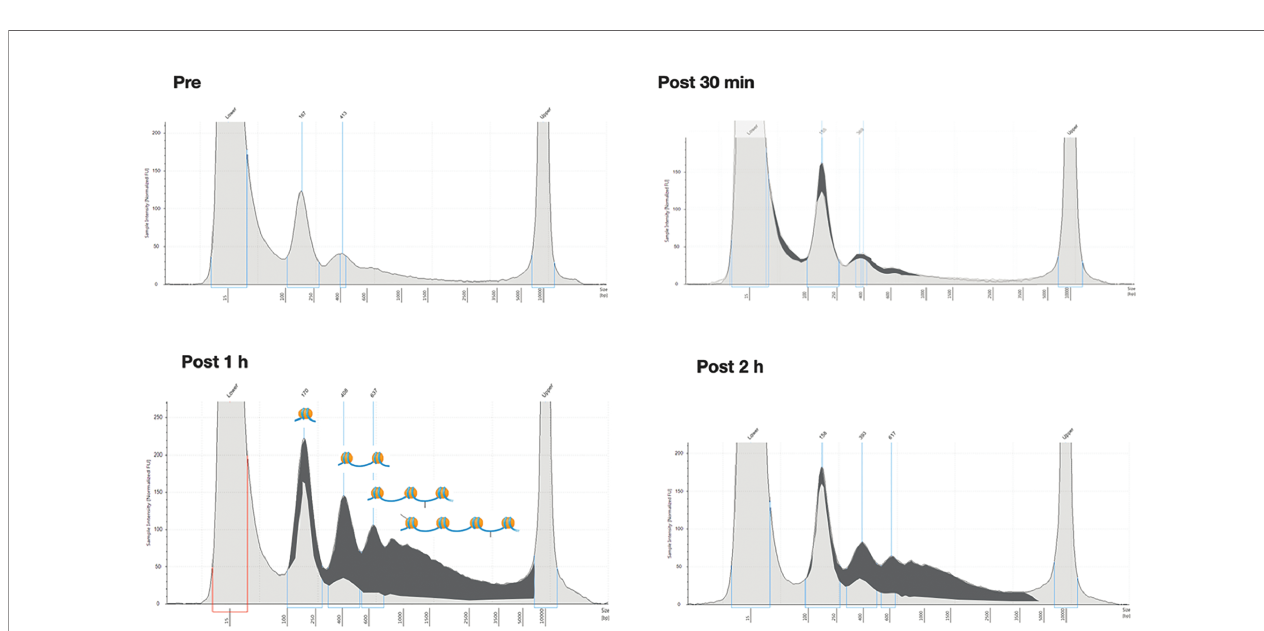
FIGURE 2 | Overall size distribution of ccfDNA pre- and post-biopsy. Representative Tape station electropherograms showing DNA fragment size distribution in ccfDNA isolated from plasma of a single patient (P20) pre-biopsy and after 30 min, 1 hour, and 2 hours from the procedure. The longer fragments appearing after 1 and 2 hours post-biopsy are highlighted in dark grey as the portion of the area under the curve after subtracting the pro fi le obtained for pre-biopsy ccfDNA. In the 1h panel a schematic representation of the predicted nucleosomal structure of the detected fragments is depicted above the pro fi